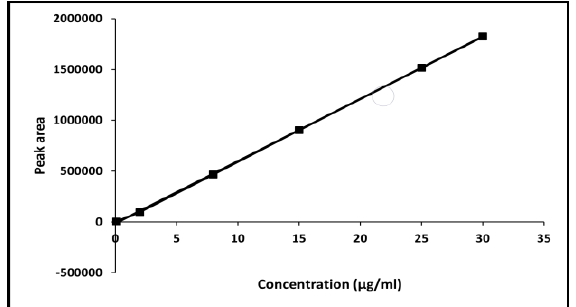
Fig. 5 . Calibration curve for determination of CSOL in the pure form at λ max = 230 nm using the proposed method. Table 4 . Assay validation findings of the proposed HPLC method for determination of HEX, CHX &